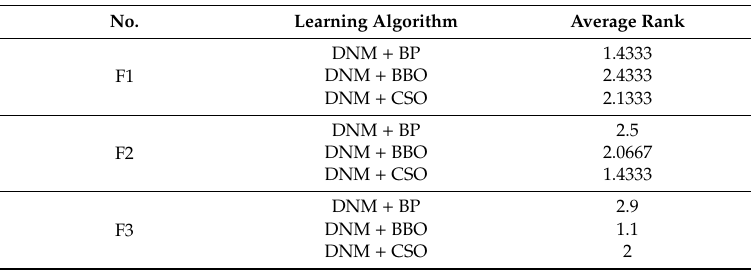
Table 19. Average ranks of methods in F1, F2 and F3.